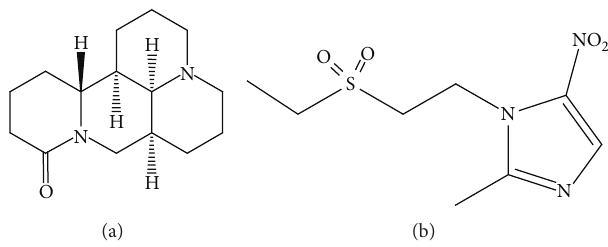
Figure 1: Chemical structures of matrine (a) and tinidazole